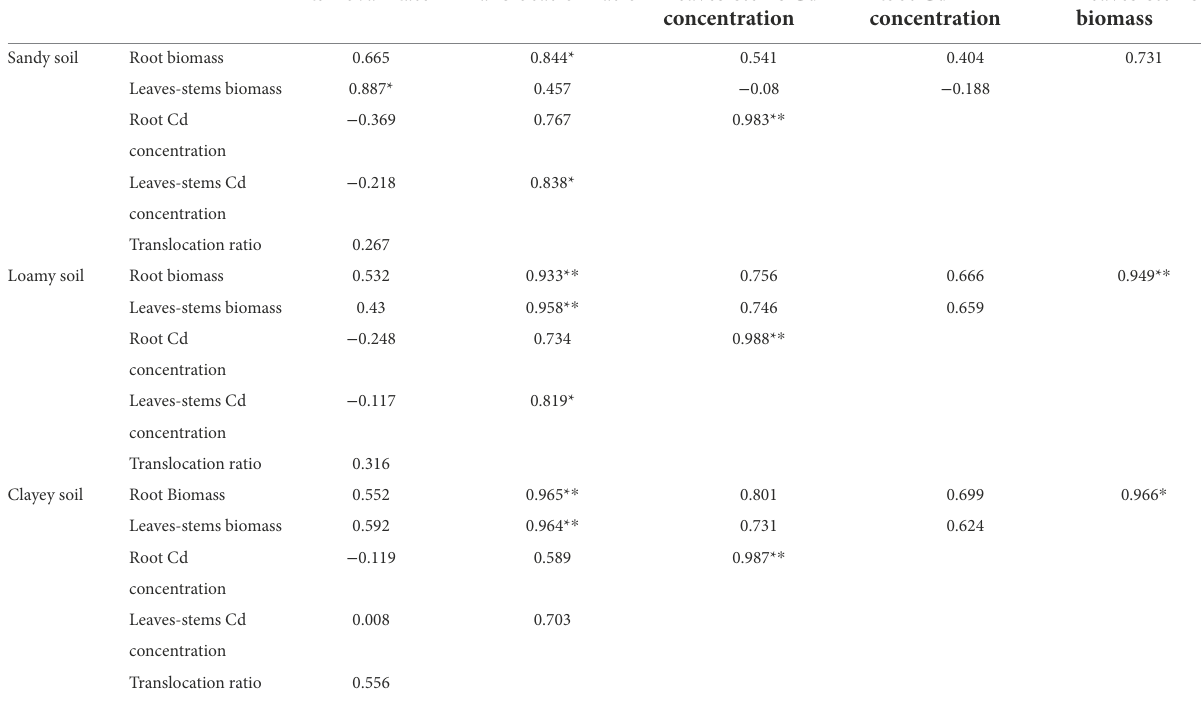
TABLE 3 Correlation analysis of various indicators on different soil types of Sorghum sudanense (Person correlation analysis).